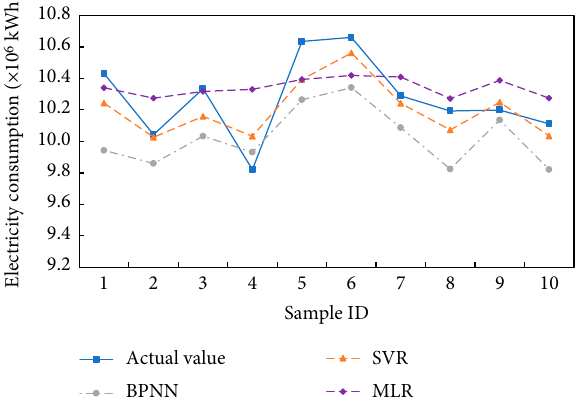
Figure 8: Predicted results by the SVR, BPNN, and MLR